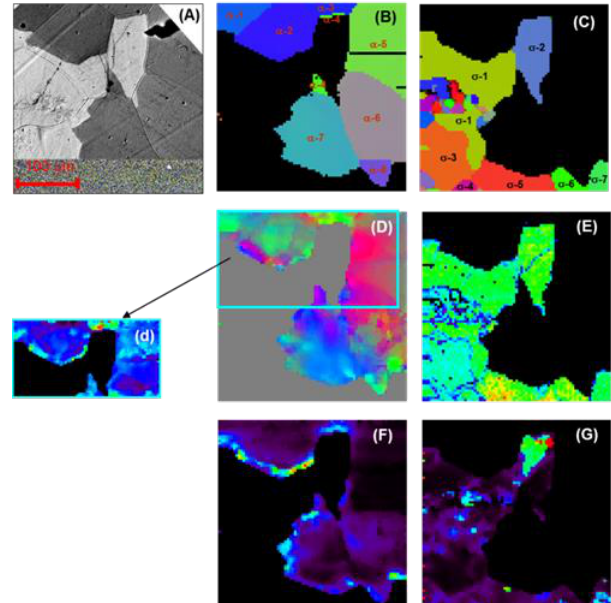
Figure 2. (Color online) Micro X-ray diffraction scanning of the sample surface as shown on the SEM image ( A ). ( B , C ) are the corresponding crystalline orientation maps, represented in the RGB system (Red: (001), Green: (011) and Blue: (111)) for the α and σ phases respectively. ( D , E ) are deviatoric strain maps, also represented in the RGB, system with the following correspondence for directions R: xx, G: yy et B: zz for α and σ phases respectively; Insert ( d ) shows the stress map for the α phase corresponding to a smaller area on the sample surface. ( F , G ) are the Laue spot broadening maps (related to dislocation densities) for the α and σ phases respectively.